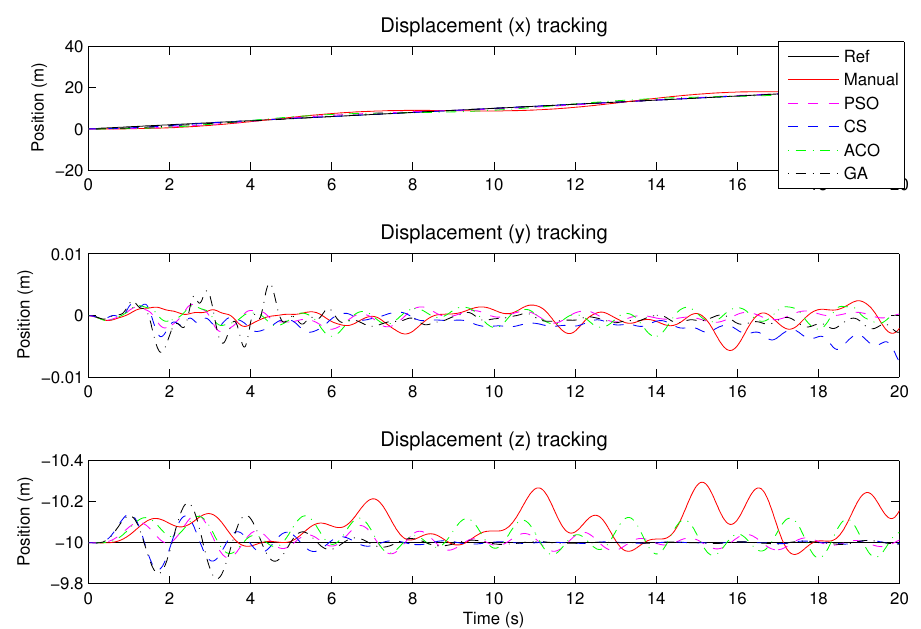
Figure 9. The controlled rotorcraft positions with the forward translation at 1 m/s.